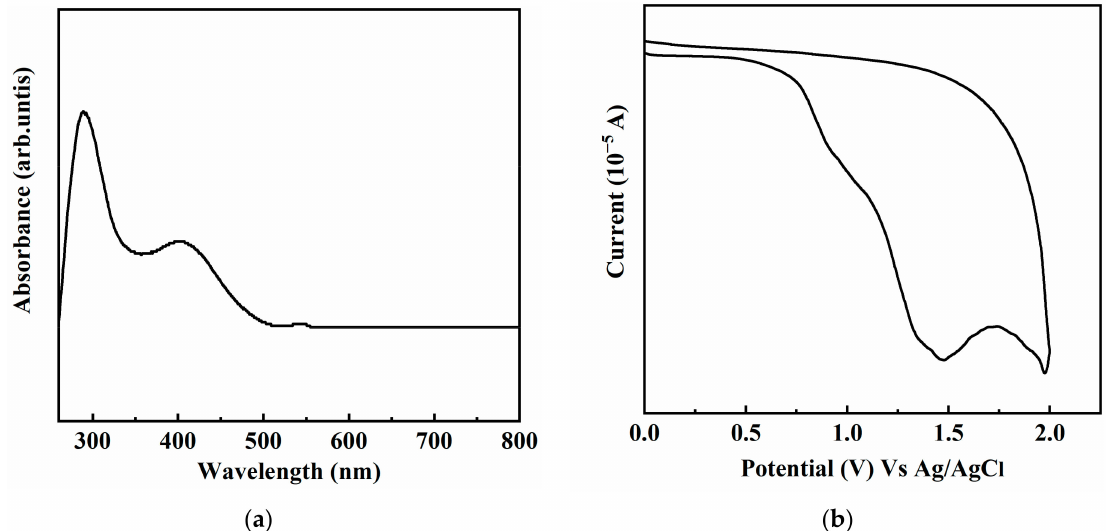
Figure 2. ( a ) UV absorption spectrum of PIB. ( b ) CV curve of PIB.